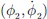
The experimental results.For f
10 = 158.47 BPM and f
20 = 156.52 BPM, we present (a) the time evolutions of ϕ
1,2, where envelopes of ϕ
1,2 exhibit anti-phase synchronization; (b) the phase trajectory in the (ϕ,ϕ˙) space; and (c) the Poincaré maps. (d) The variation of the phase-locking ratio, r, as a function of the natural frequency of the second metronome, f
20. The arrow denotes the point at which r = π / 3.1.